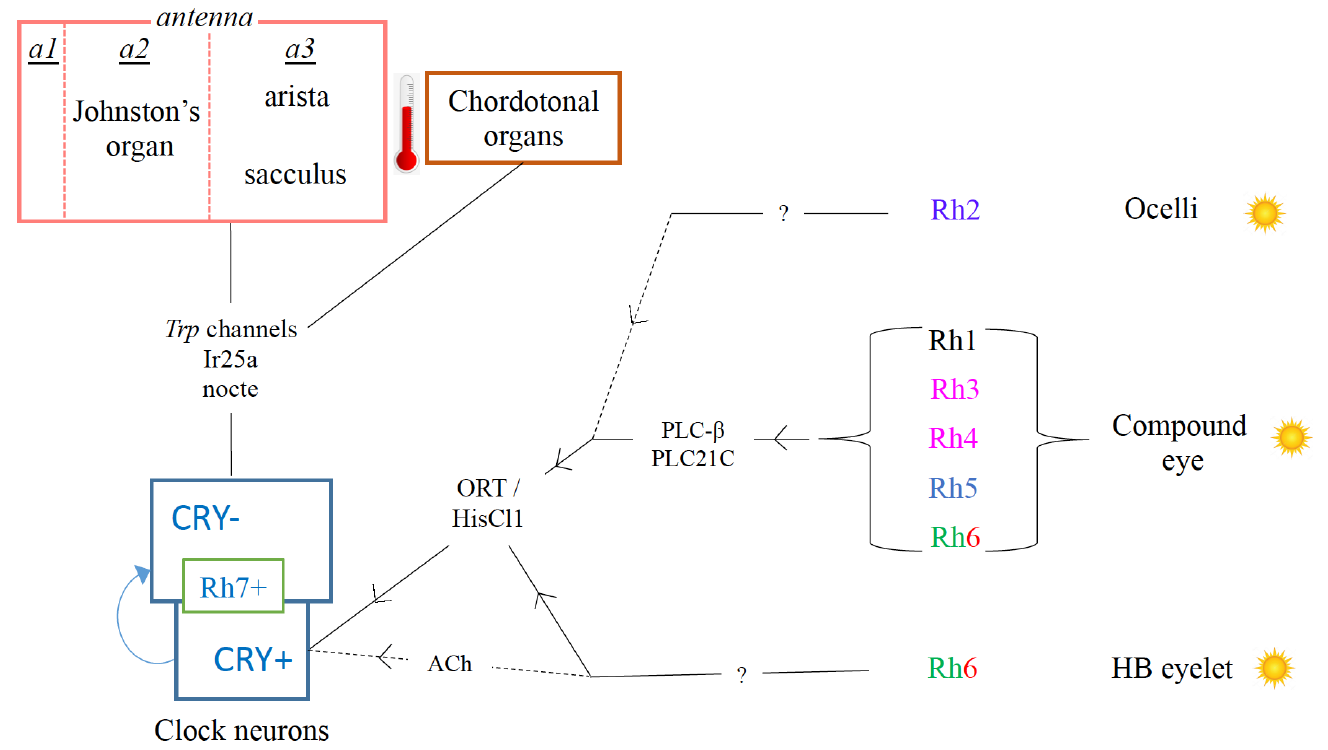
Figure 2. Inputs to the clock. The two major time-cues for the insect circadian clocks are light and temperature. Light is received by the visual system and by intracellular CRY and Rh7 present in some of the clock neurons in the brain. The light inputs from the visual system is first transduced by different rhodopsins (Rhs) in the compound eye, ocelli and HB eyelet, and finally reaches the clock through parallel, multi-synaptic circuits involving histaminergic, cholinergic (and potentially peptidergic) pathways. Temperature receiving sensory units present in the body (Chordotonal Organs), or the tripartite (a1–a3) antenna of the head (particularly, in the Johnston’s organ, arista and sacculus) feed information to mostly the CRY( − ) clock neurons via indirect connections. Thermal Trp channels (TrpA1, pyrexia), ionotropic receptors (Ir25a) and genes that control the structural integrity of the chordotonal organs (nocte) have been implicated in temperature entrainment (reviewed in [55]).